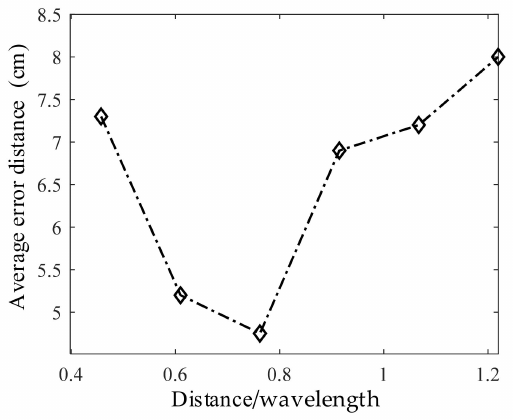
Figure 17. Effects of antenna distance on the average positioning